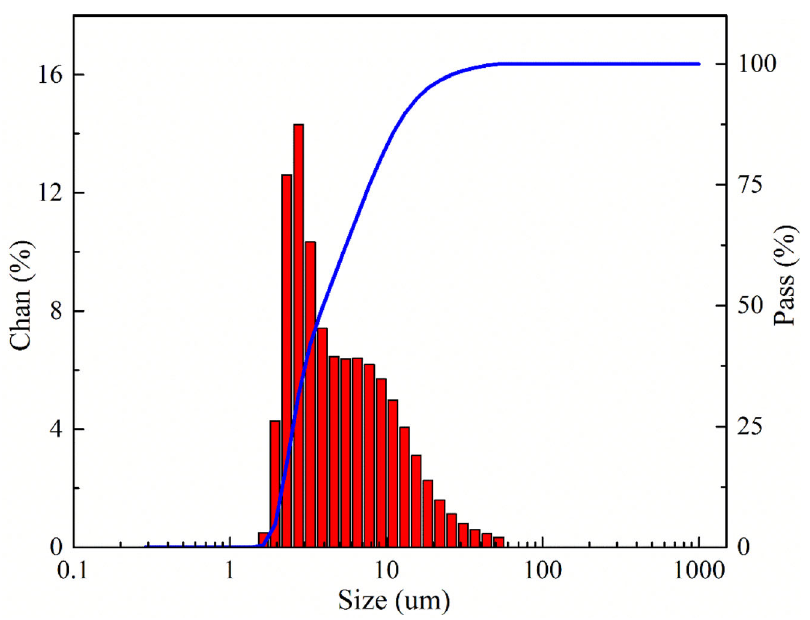
Fig. 2 Particle size distribution of kaolinite